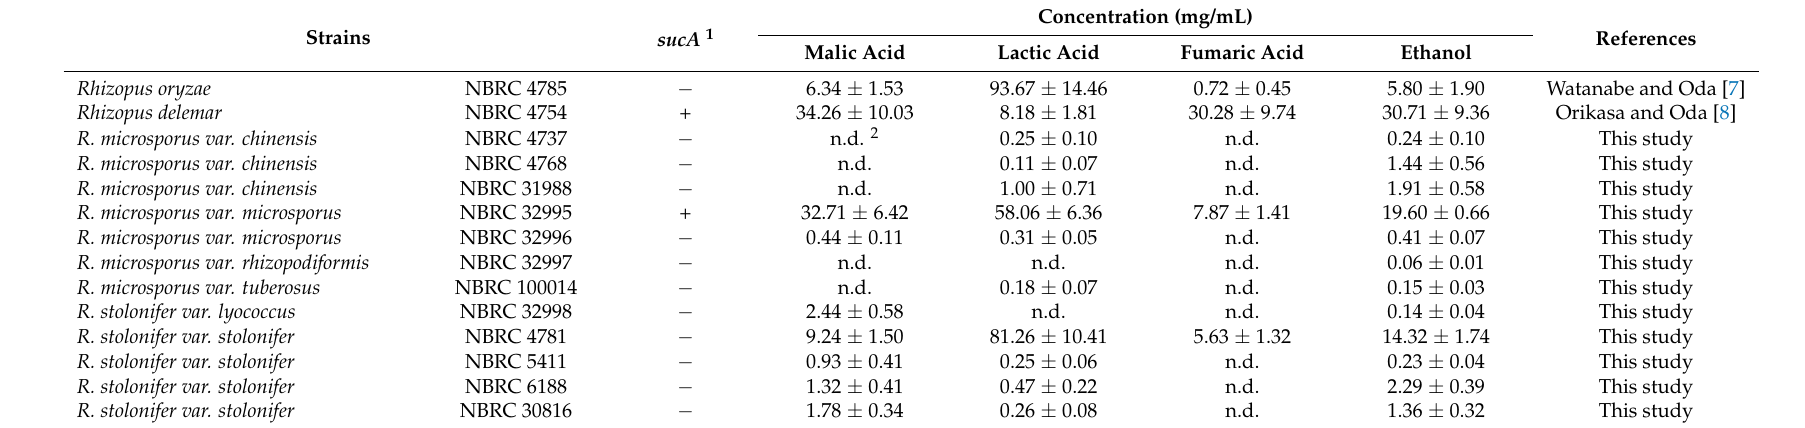
Table 1. Detection of sucA gene and the production of organic acids and ethanol in Rhizopus